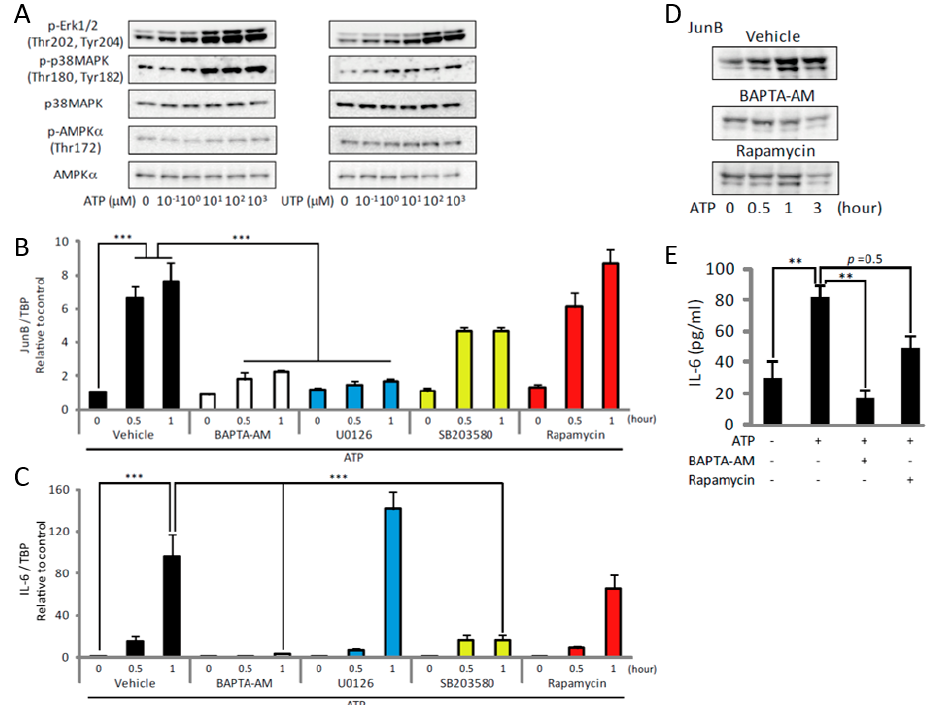
Figure 4. ATP upregulates JunB and IL-6 by activating Erk1/2, p38 MAPK and mTOR in C2C12 myotubes. ( A ) Concentration-dependent effects of ATP (left) or UTP (right) on phosphorylation of Erk1/2, p38 MAPK and AMPK α ( n = 4). ( B , C ) Gene expression analysis showing the effects of BAPTA-AM (white), U0126 (blue), SB203580 (yellow) and rapamycin (red) on the ATP-induced expression of JunB ( B ) and IL-6 ( C ) ( n = 4). ( D ) Representative Western blots showing the effects of BAPTA-AM or rapamycin on the ATP-induced increase of JunB ( n = 4). ( E ) Effects of BAPTA-AM or rapamycin on the ATP-induced increase of IL-6 protein level ( n = 4). The concentration of ATP in ( B – E ) was 100 µM and the duration of treatment in all experiments shown in this figure was 30 min. ** p < 0.01, *** p < 0.001 by ANOVA with Tukey-Kramer test. Error bars indicate S.E.M.